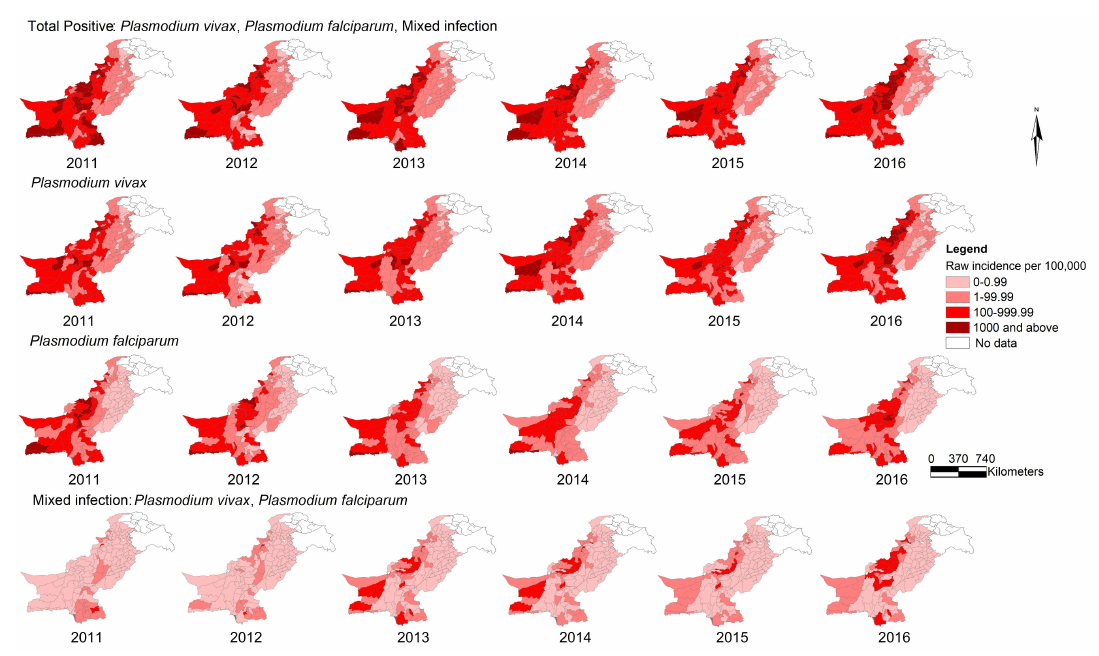
Figure 3. Raw incidence (per 100,000) of malaria by type at the district level in Pakistan, 2011–2016.